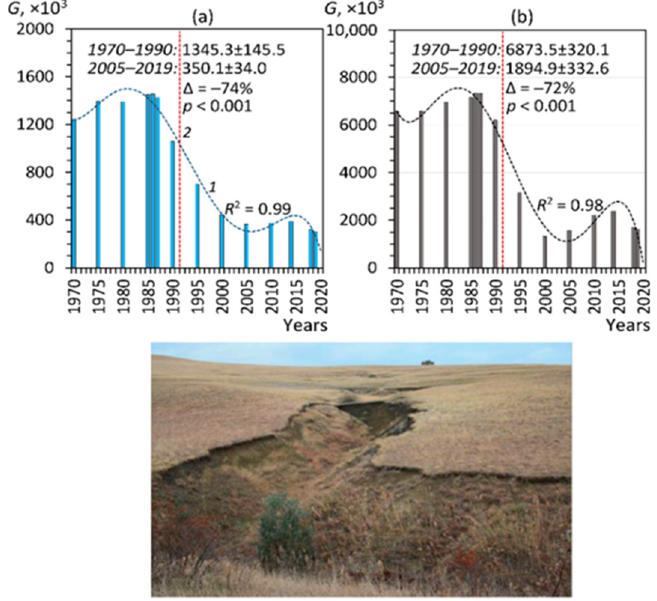
Figure 14. Changes in the number ( G , units) of cattle ( a ) and sheep and goats ( b ) in all types of farms in the Stavropol Krai (SW Russia) between 1970–1990 and 2005–2019. R 2 —the coefficient of approximation for the fifth-degree polynomial trend line ( 1 ); 2 —the time border between the former USSR and the Russian Federation; ∆ —relative changes; p —the probability of statistically significant difference for the indicated averaged values between the periods (the Student’s t -test). The photography (taken by A.G. Sharifullin, May 2017): The gully head (44°58 ′ 46.4 ″ N, 42°42 ′ 40.4 ″ E), overgrown with steppe vegetation, on the left-side slope of the Kalaus River valley near the village of Sergiyevka of the Stavropol Krai, SW Russia (see Figure 1).